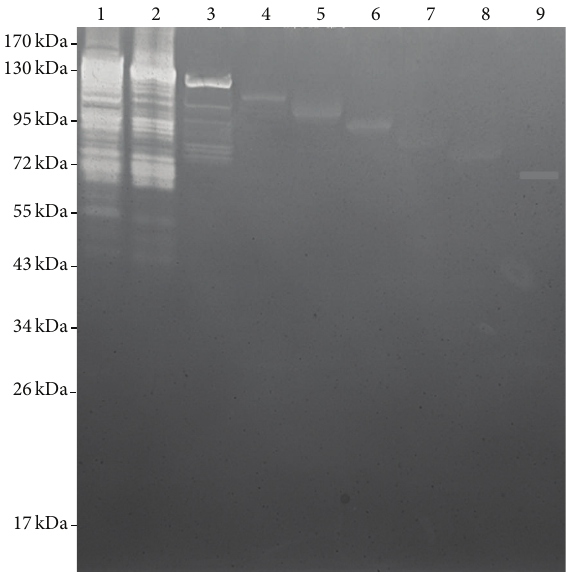
Figure 3: Zymographic detection of the autolytic activity in recom- binant His-tagged Atl. Protein extracts from E. coli BL21 cells grown with IPTG were used in this study. The protein extract was separated by 12.5% SDS-gel electrophoresis. The SDS gel was impregnated with autoclaved S. aureus RN450 cells. Autolytic activity was detected by renaturing the autolysins by incubation of the gel in 50 mM Tri-HCl buffer,pH7.5,containing0.05%TritonX-100.Lane1:fulllengthHis- tagged Atl; lane 2: Atl-1; lane 3: Atl-2; lane 4: Atl-3; lane 5: Atl-4;